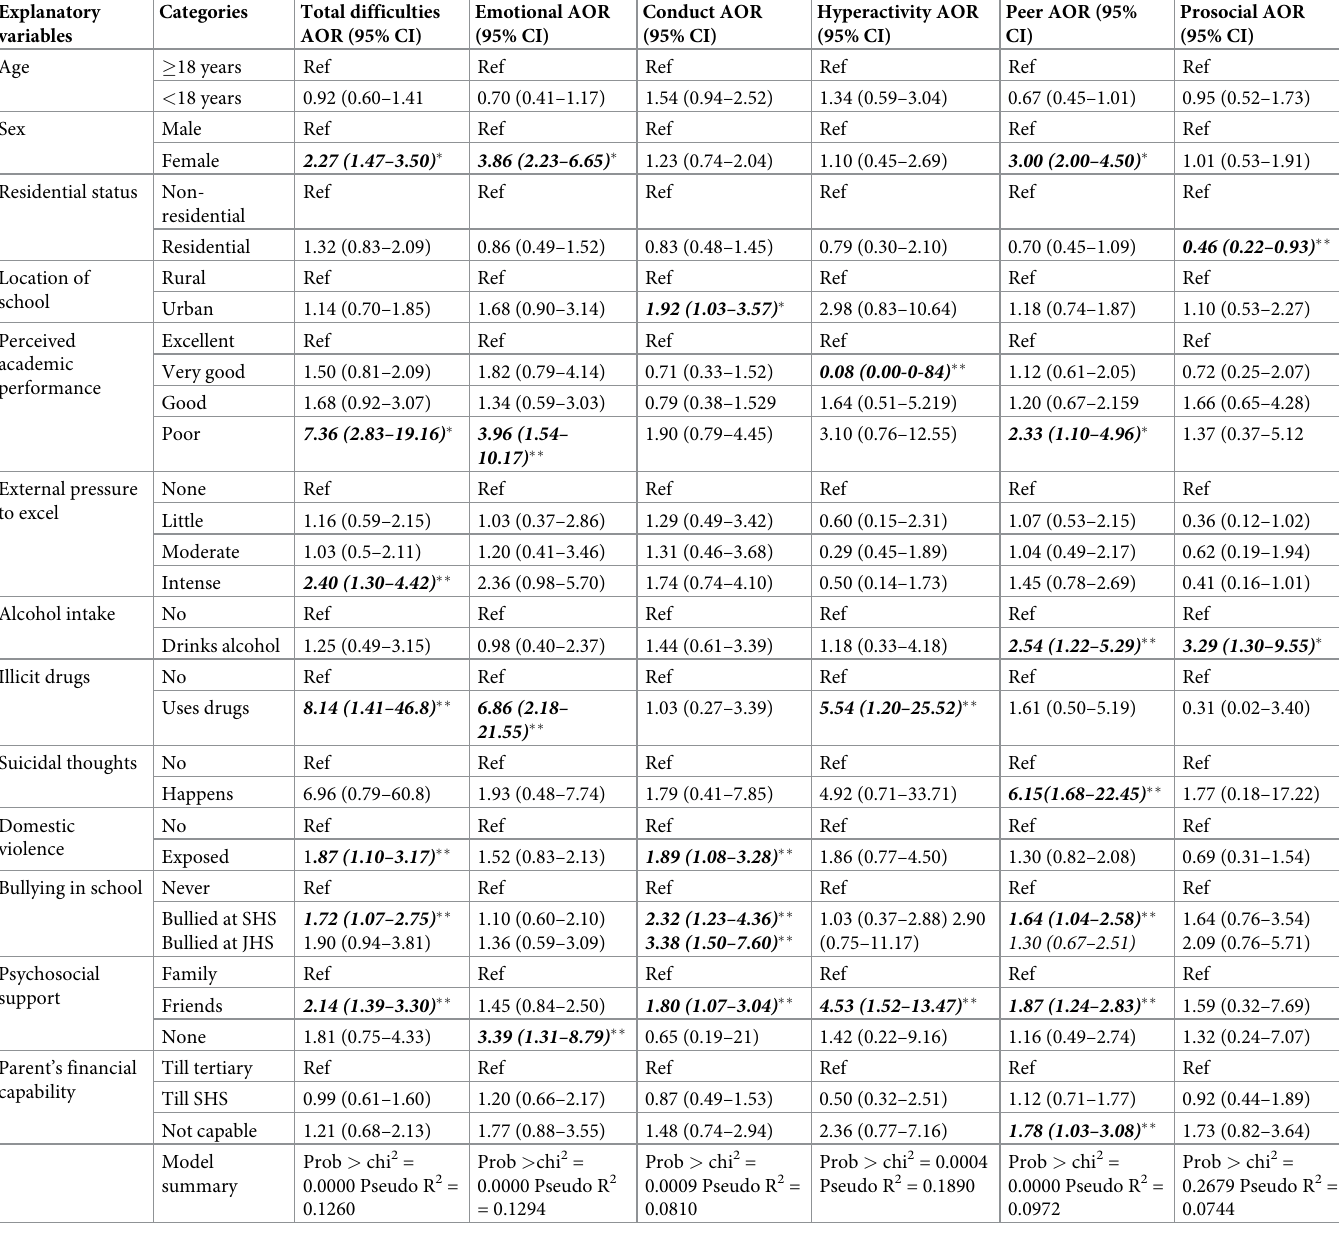
Table 3. Ordinal logistic regression model showing the predictors for experiencing mental health difficulties and the subscales. Explanatory